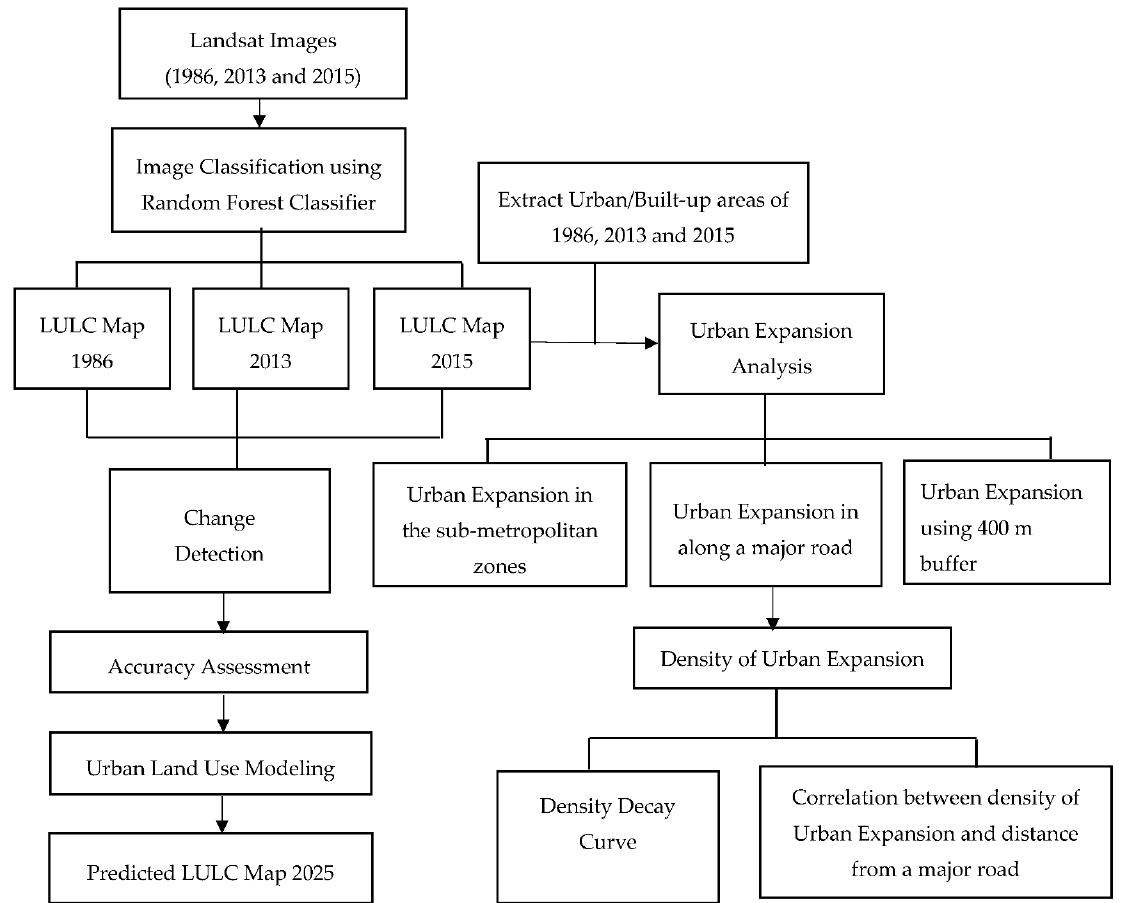
Figure 2. Methodology flowchart adopted for the study.